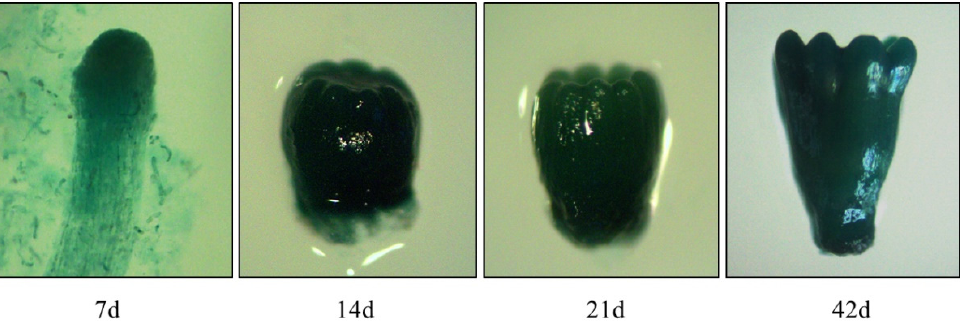
Figure 7. Histochemical detection of the GUS staining in somatic embryos from transgenic cell lines pLaTCTP:GUS at different developmental stages detected in 7 days (7 days, 14 days, 21 days, and 42 days).